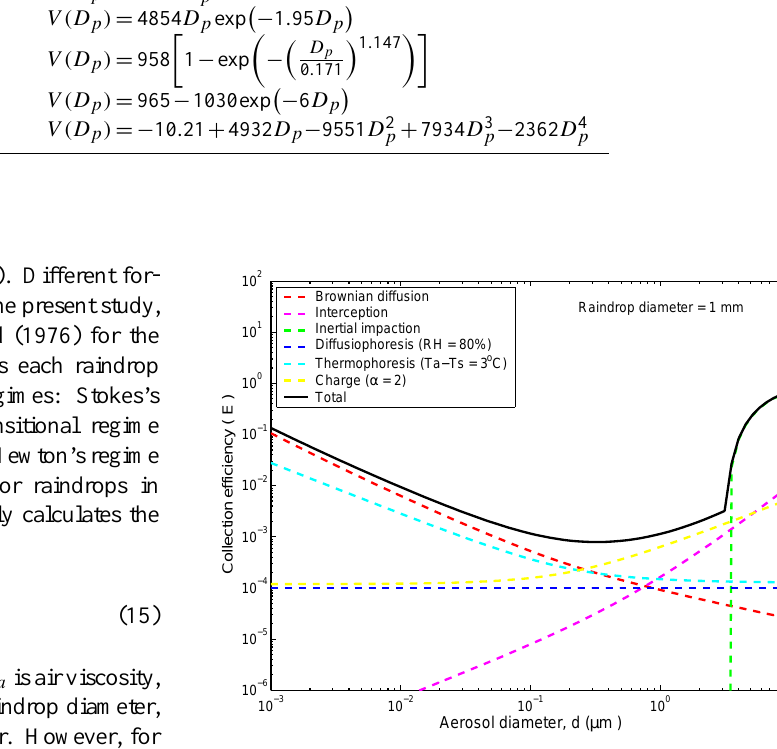
Fig. 1. Contributions of various collection processes to the collec- tion efficiency E(d p ,D p ) as a function of the aerosol particle size for a raindrop with diameter of